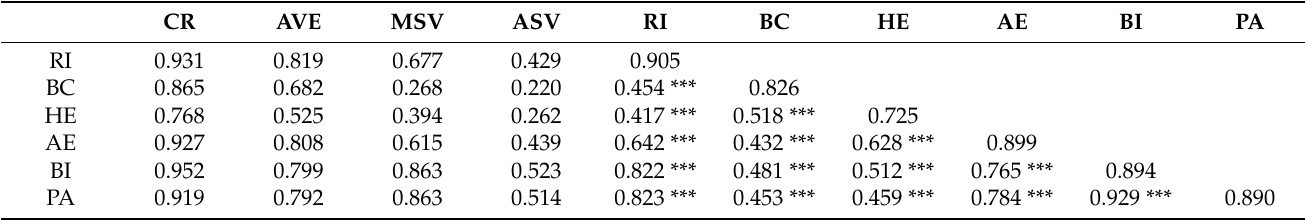
Table 4. Correlation and discriminant validity of the